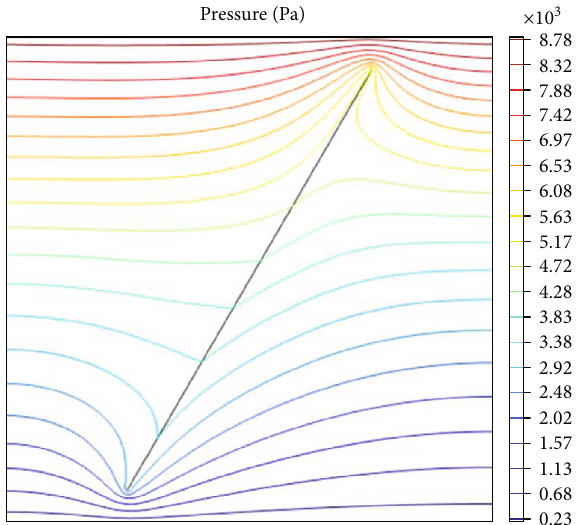
Figure 3: The pressure distribution contour of the MF model. Concentration (mol/m 3 )